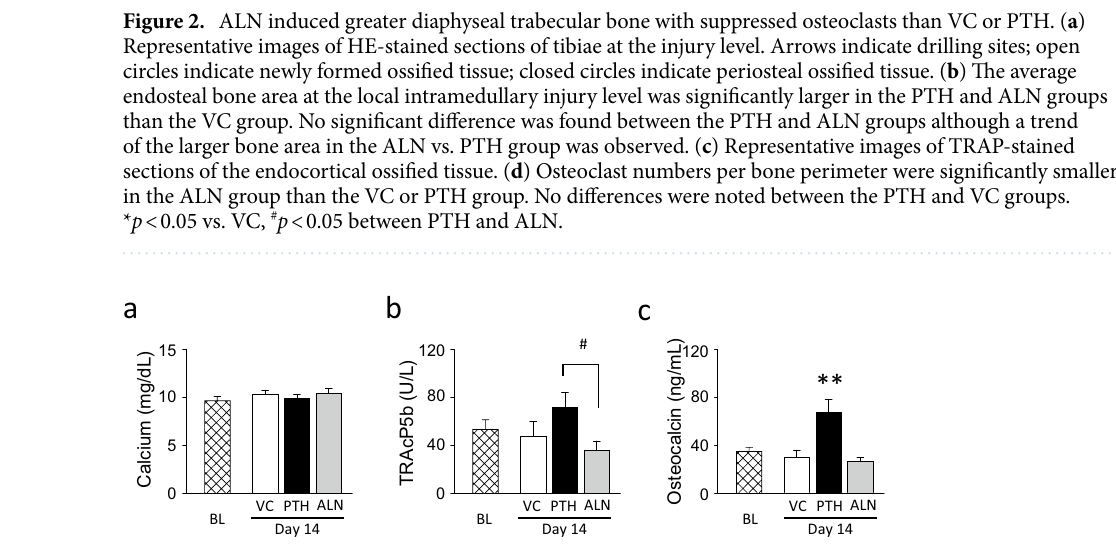
Figure 3. Serum biochemistry. ( a ) Serum calcium levels were maintained within the normal range regardless of treatment. ( b ) No statistical differences were noted in the serum TRAcP5b levels in all treatment groups relative to BL. There was a significant difference at day-14 between the PTH and ALN groups. ( c ) Serum osteocalcin levels were significantly elevated in the PTH group at day-14 in comparison to BL and the other groups at day- 14. No difference was noted between the BL and day-14 ALN or VC groups. ** p < 0.01 vs. BL, # p < 0.05 PTH vs.